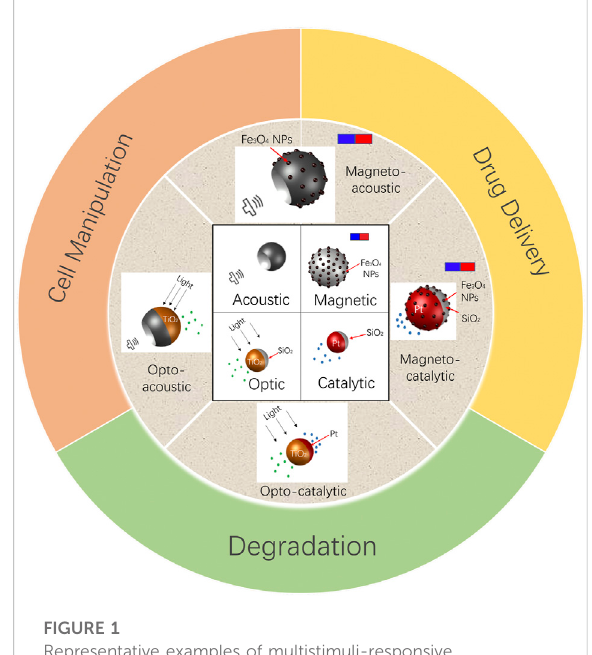
FIGURE 1 Representative examples of multistimuli-responsive microbots for different